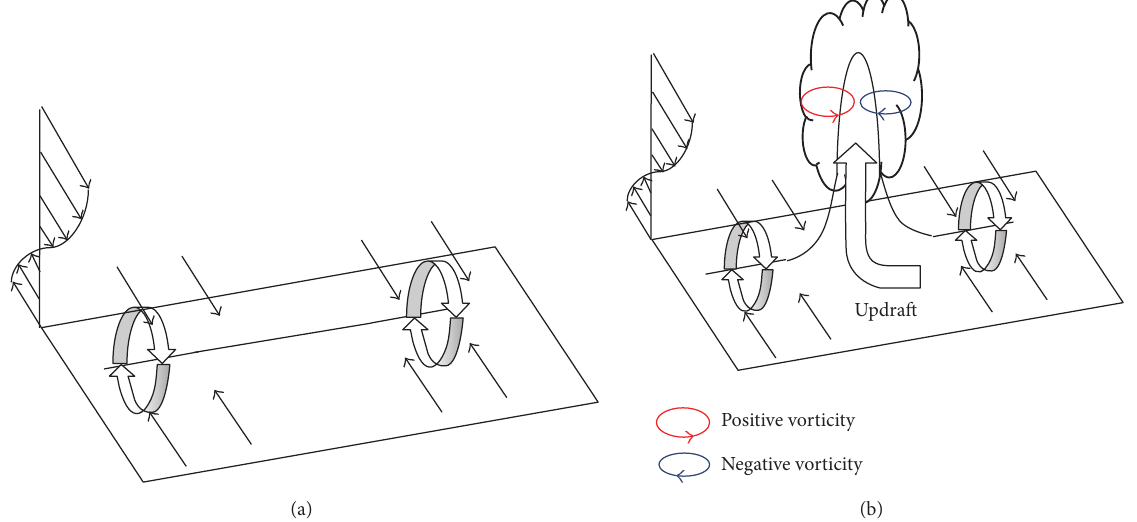
Figure 5: Schematic figures of formation of a vertical vortex tube. Circular arrows show circulations of horizontal vortex tube. (a) The vertical shearofhorizontalwindgeneratesahorizontallyorientedvortextube.(b)Updrafttiltsahorizontalvortextubeintoaverticalone(reproduced based on [15–17]).